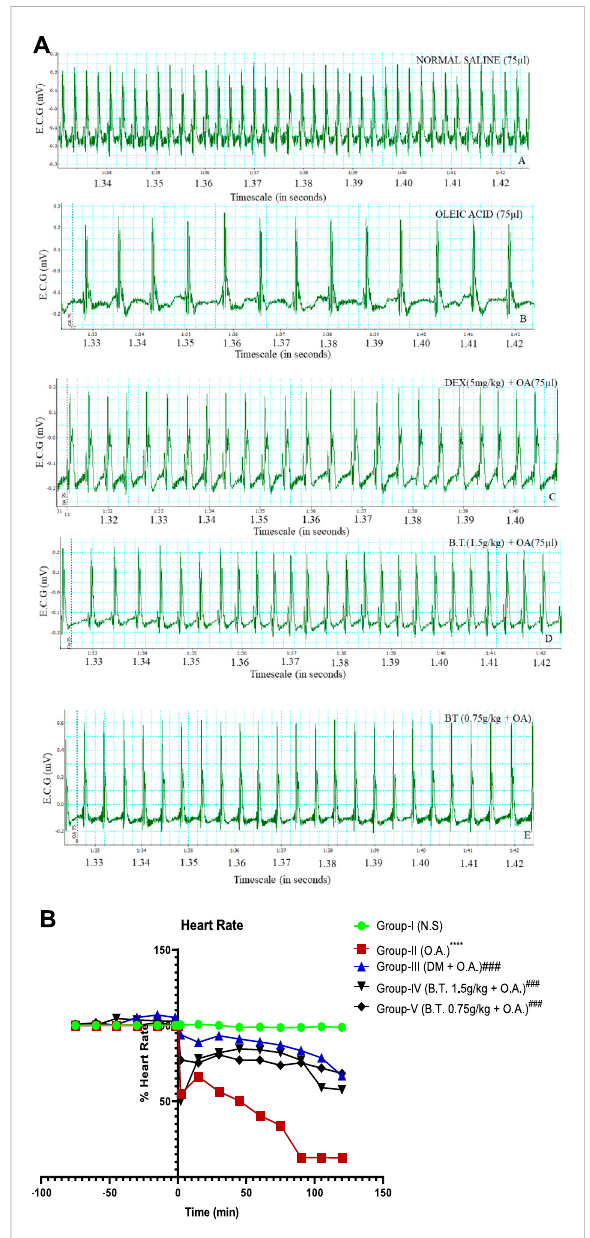
FIGURE 8 (A,B) : Heart rate comparison between the groups through chart recorder (A) and statistically (B) . (A) : Heart rate frequency denoted by green colour in real-time in the groups I, II, III, IV and V at a 10:1 aspect ratio obtained from a computerized chart recorder where x -axis represents ECG (mV) and y -axis represent timeline. Group I shows the basal HR value, while bradycardia is prominent in group II.This wascorrectedin treatment group IV, as a near normal frequency can be seen after instillation of oleic acid (denotedasdottedline)instillation. (B) :Heartratecalculatedasthe initial percentage at 0 min (denotes the time of instillation of oleic acid, except for group I). The results are expressed as mean ± SD ( n = 6). Statistical analysis was performed using the one-sample T test and Wilcoxon test where *, p < 0.05, ***, p < 0.001,****, p < 0.0001 in comparison to group I and # ,p < 0.05, ### ,p < 0.001 and #### ,p < 0.0001 in comparison to group